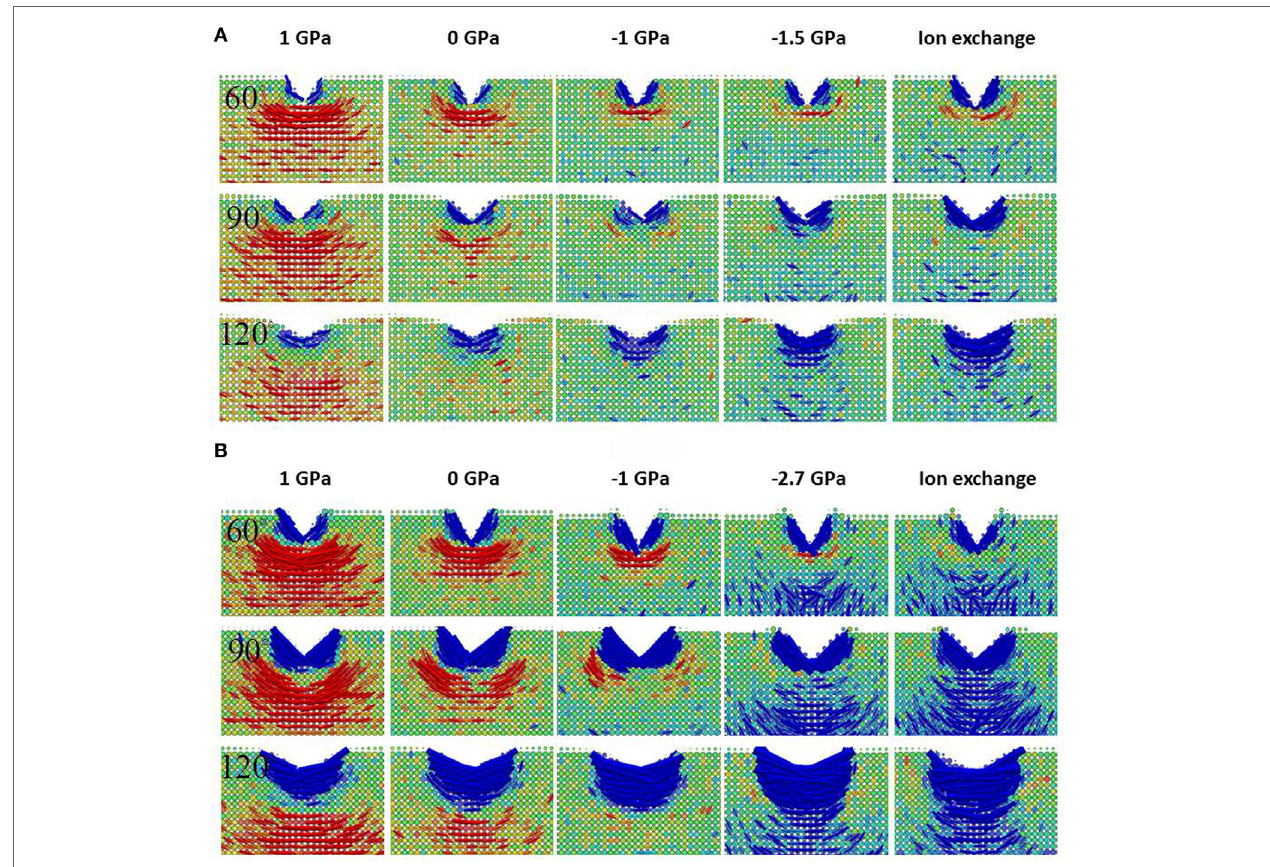
FigUre 3 | close-up view of the first principal stress field during loading for the base glass with high free volume in (a) and low free volume in (B) . The indentation depth is 10 nm. The apparent voxel size is rendered proportional to the number of atoms it contains in order to better depict the sinking-in and pileup on the surface of the sample. Sinking-in is more apparent in (a) , and pile-up is more apparent in (B) . Sinking-in increases with increasing indenter angle, while pileup decreases with increasing indenter angle. The color bar is the same as in Figure 2 . From left to right, each column corresponds to a different initial σ xx as labeled on the top. The last two columns have the same initial σ xx , which is achieved via mechanical and ion exchange methods, respectively. From left to right, the free volume effectively decreases. From top to bottom, each row corresponds to the indenter angle of 60°, 90°, and 120°,